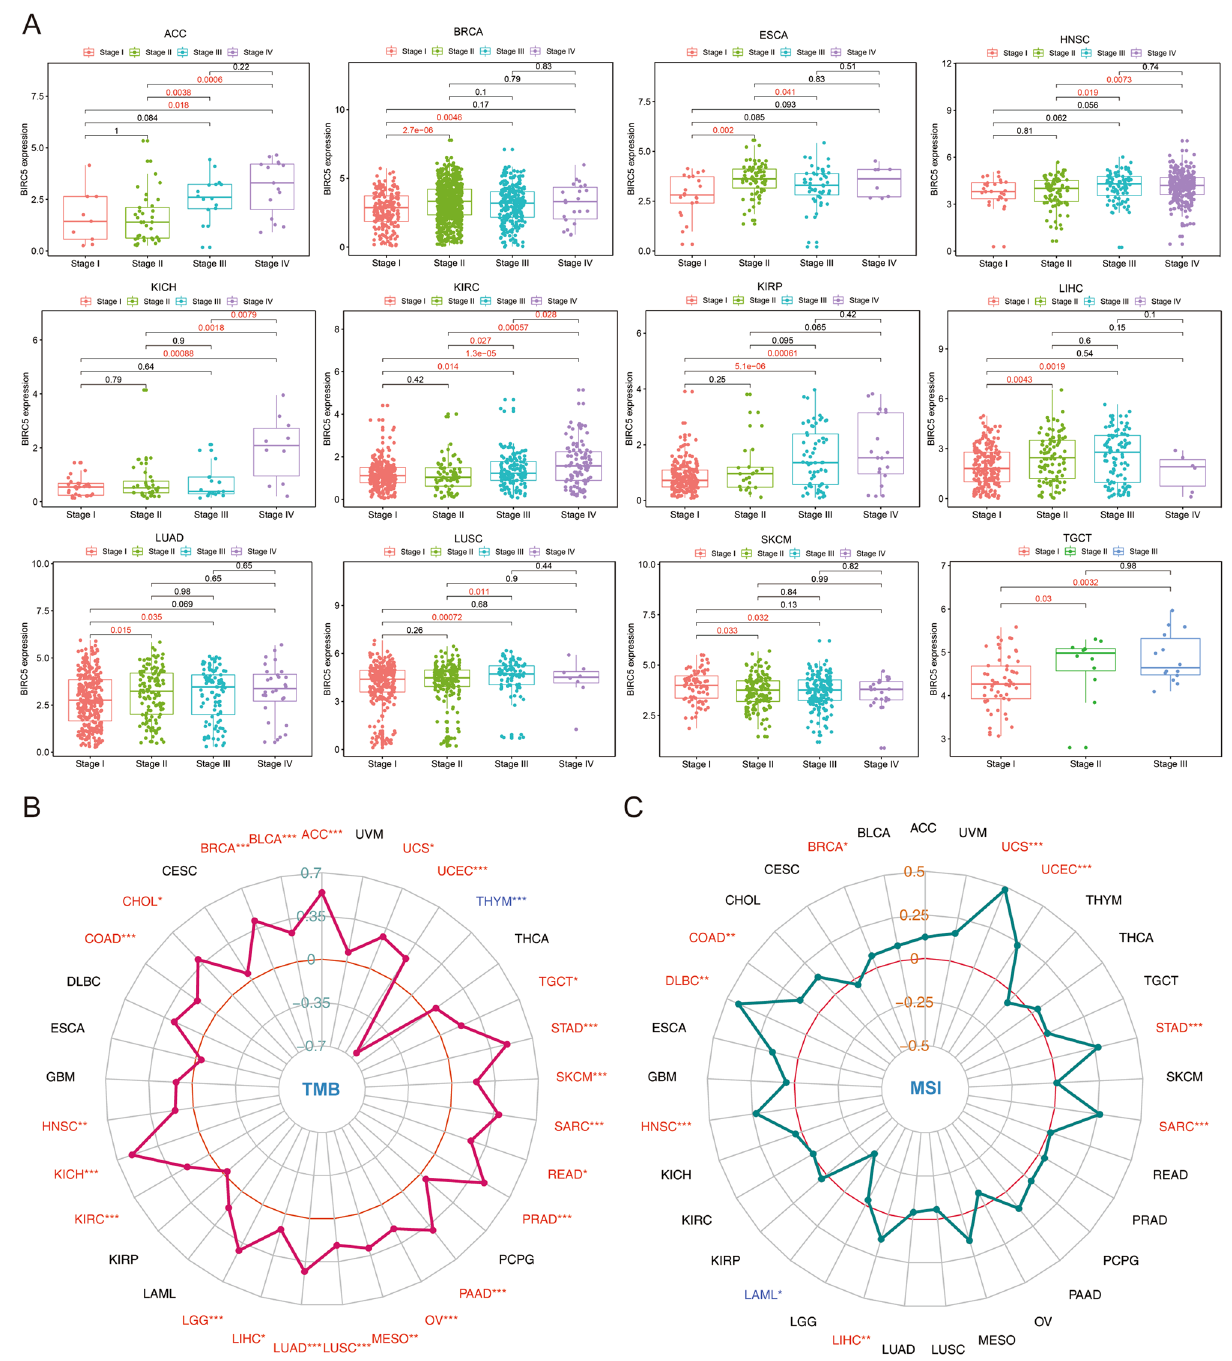
Figure 3. The relationship between BIRC5 expression level and pathological characteristics of tumor patients the relationship between. ( A ) BIRC5 expression level and Stage grade of cancer patients the relationship between. ( B ) BIRC5 expression level and Tumor mutation burden (TMB) in cancer patients the relationship between. ( C ) BIRC5 expression level and microsatellite instability (MSI) in cancer patients. * P < 0.05. * P < 0.01. * P < 0.001. The figure was performed using R version 3.6.1 (2019-07-05) 46